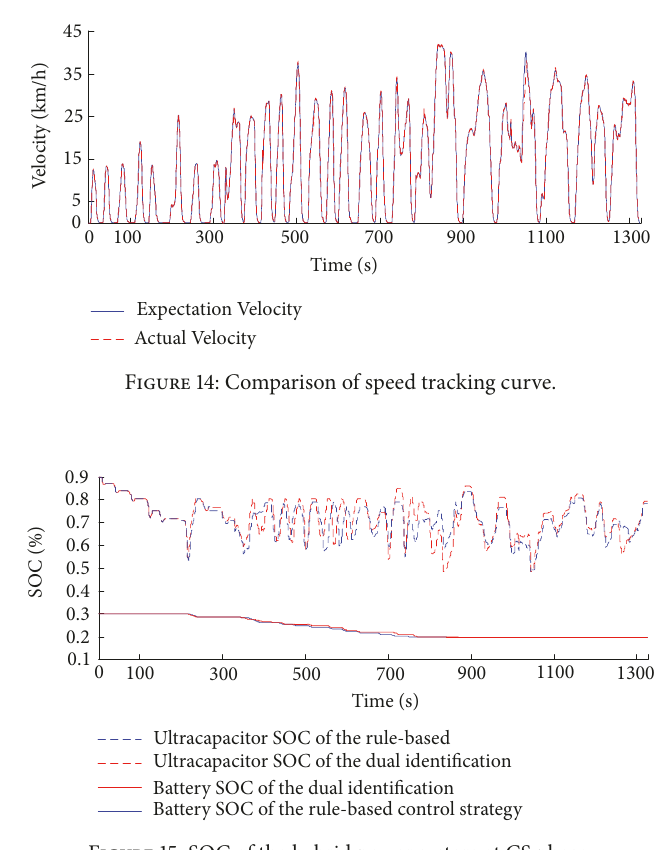
Figure 15: SOC of the hybrid power system at CS phase.